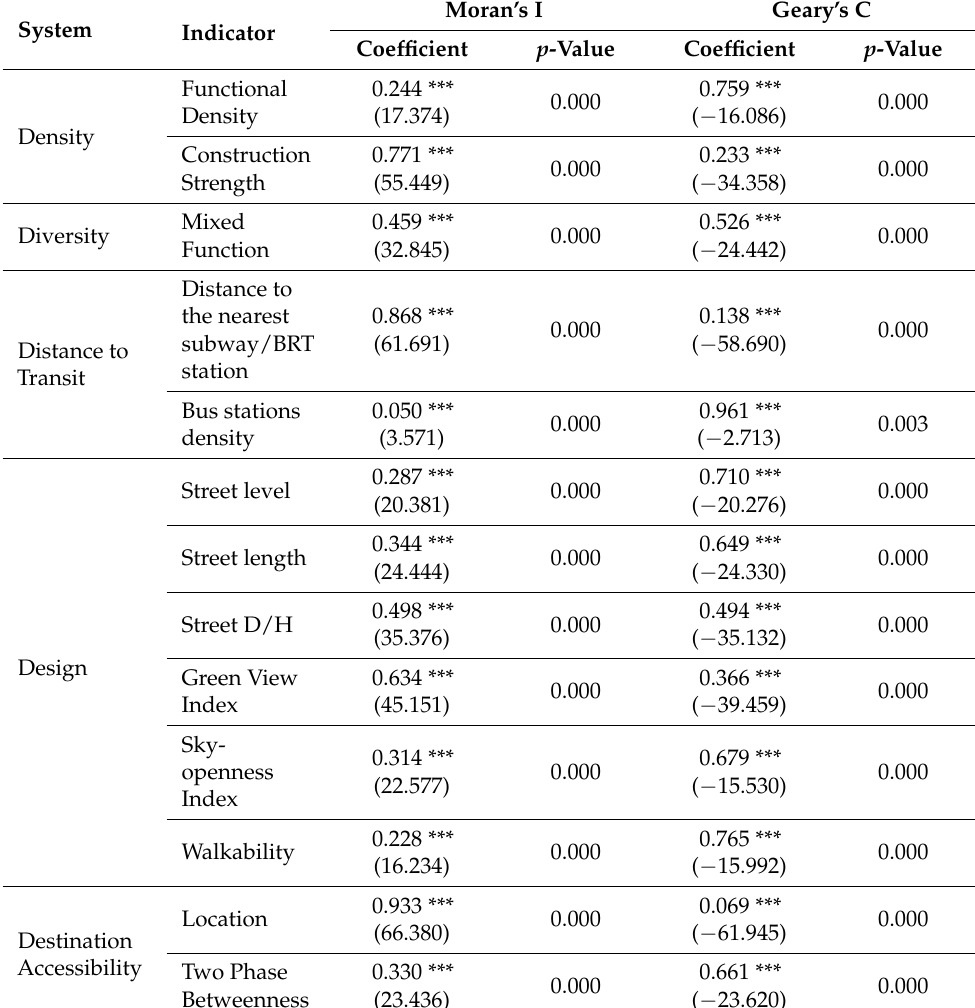
Table 2. Spatial correlation of independent